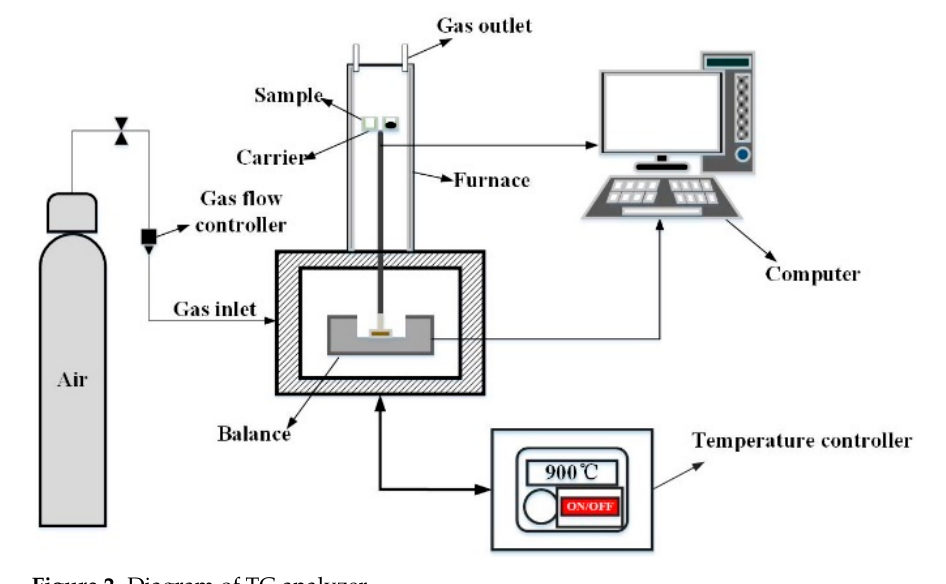
Figure 2. Diagram of TG analyzer.